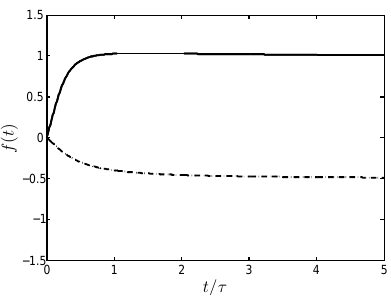
Figure B1. Function f (t) in the case of strike-slip (solid line) and dip-slip (dashed line). Time is in units of the characteristic diffusion time τ